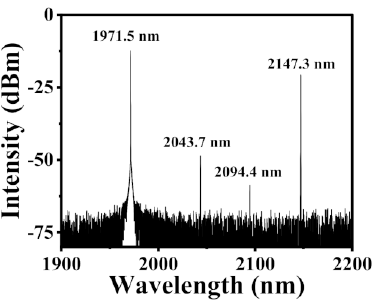
Figure 4. The output spectrum when the pump source (repetition frequency set to 1.5 MHz, pulse width set to 10 ns) is at a maximum output power (fiber length of 16.8 m, deuterium pressure of 26.5 bar).